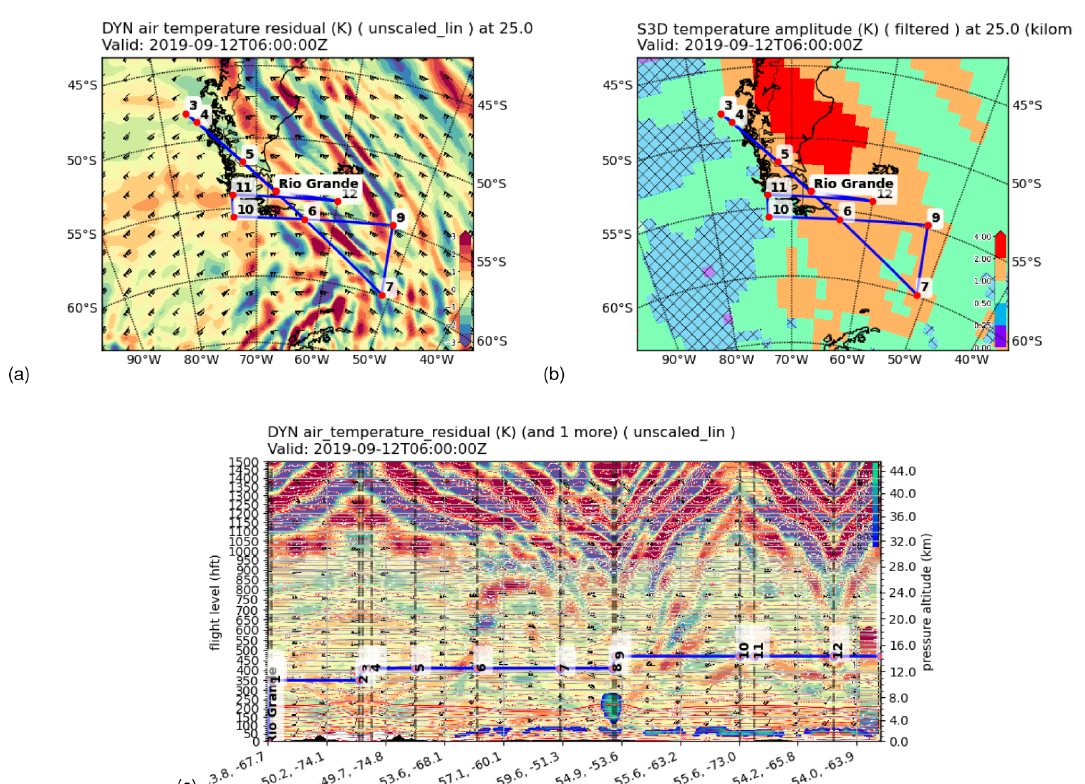
Figure 5. Gravity wave analysis figures: temperature perturbations derived from ECMWF data at 25km altitude (a) ; derived gravity wave amplitudes, with hatched regions indicating high uncertainty at the same altitude (b) ; temperature perturbations derived from one time step of ECMWF data sampled vertically along the planned flight path (c) – a cloud layer is displayed on top using the new multi-layering feature.